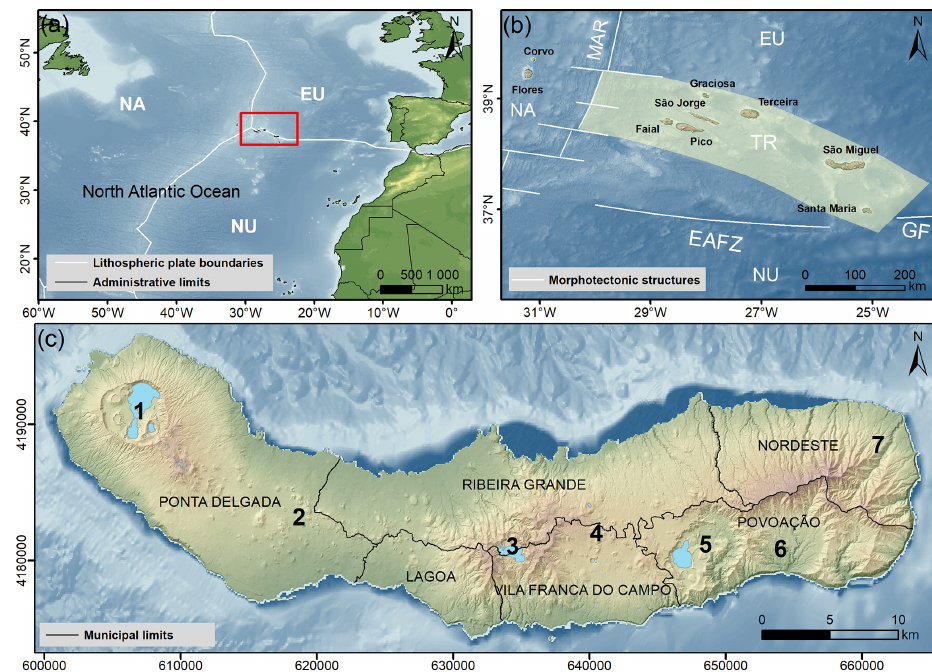
Figure 1. (a) Location of the Azores archipelago in the North Atlantic Ocean and relation to the triple junction between the North American (NA), Eurasian (EU) and Nubian (NU) lithospheric plates (world bathymetry and topography from the GEBCO_08 Grid; plate and country boundaries from the Environmental Systems Research Institute, ESRI). Geographic coordinates: datum WGS 84. (b) Geodynamic setting of the Azores archipelago and main morphotectonic structures of the region. MAR: Mid-Atlantic Ridge; TR: Terceira Rift; EAFZ: East Azores Fracture Zone; GF: Gloria Fault (Azores bathymetry from EMODnet Bathymetry Consortium, 2018; morphotectonic structures modified from Hipólito et al., 2010). Geographic coordinates: datum WGS 84. (c) Digital elevation model of São Miguel Island showing the volcanic systems and administrative limits of the six municipalities: (1) Sete Cidades volcano, (2) Picos fissure volcanic system, (3) Fogo volcano, (4) Congro fissure volcanic system, (5) Furnas volcano, (6) Povoação volcano, (7) Nordeste volcanic system (after Gaspar et al., 2015a). UTM coordinates, zone 26S, datum WGS